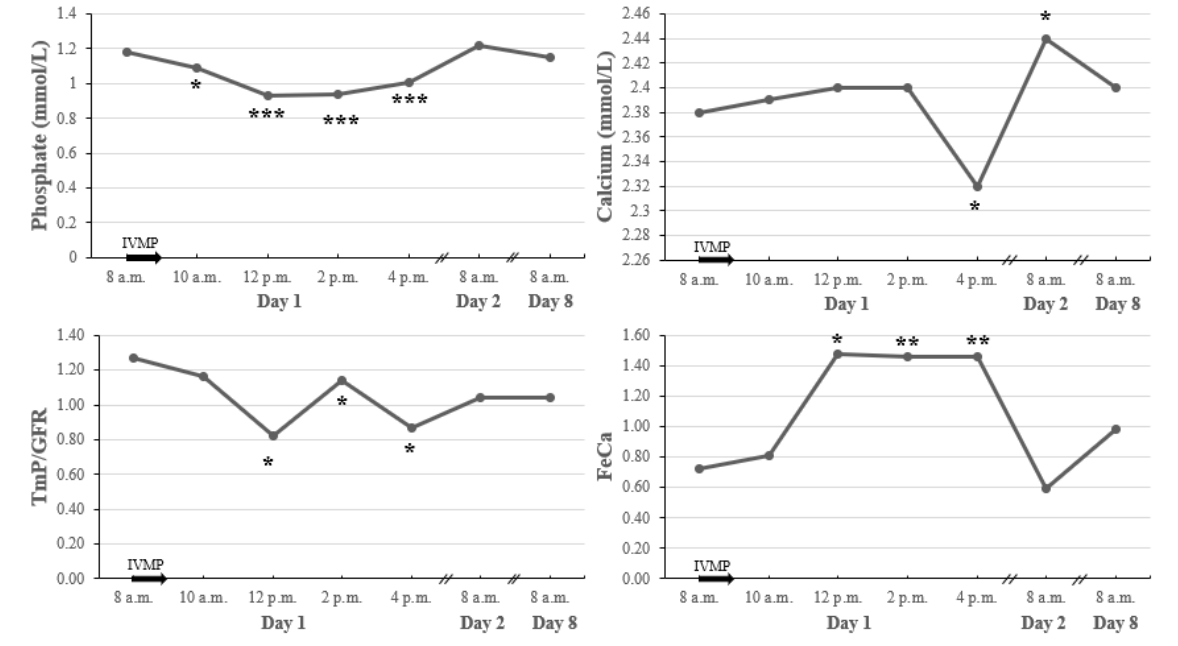
Figure 5. Early changes in calcium metabolism parameters after a single pulse of 0.5 g IVMP. * p value < 0.05 vs. baseline; ** p value < 0.01 vs. baseline; *** p value < 0.001 vs. baseline. The black arrow represents IVMP pulse of 0.5 g; IVMP intravenous methylprednisolone; TmP/GFR, tubular maximum reabsorption of phosphate adjusted to GFR; FeCa, fractional excretion of calcium.